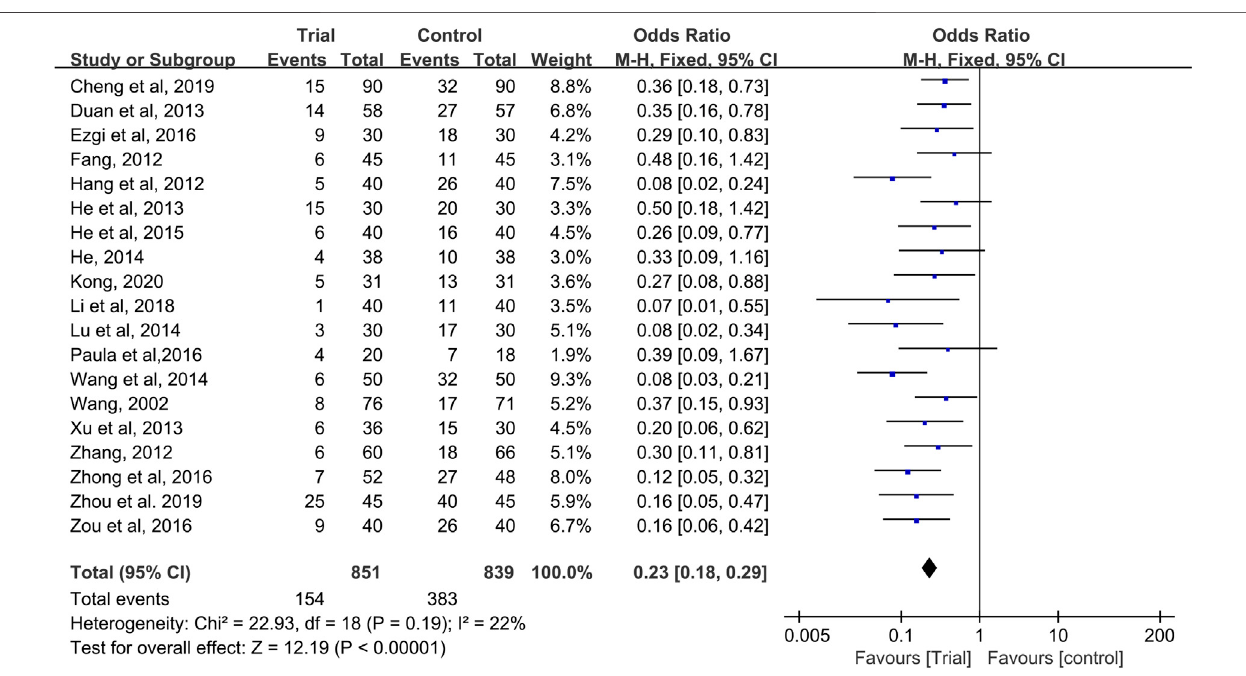
Frontiers in Pharmacology |